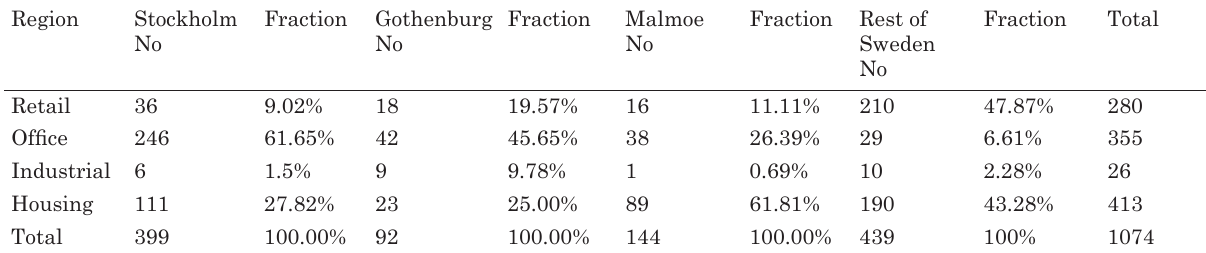
Table 3. Property type distribution of the regions region